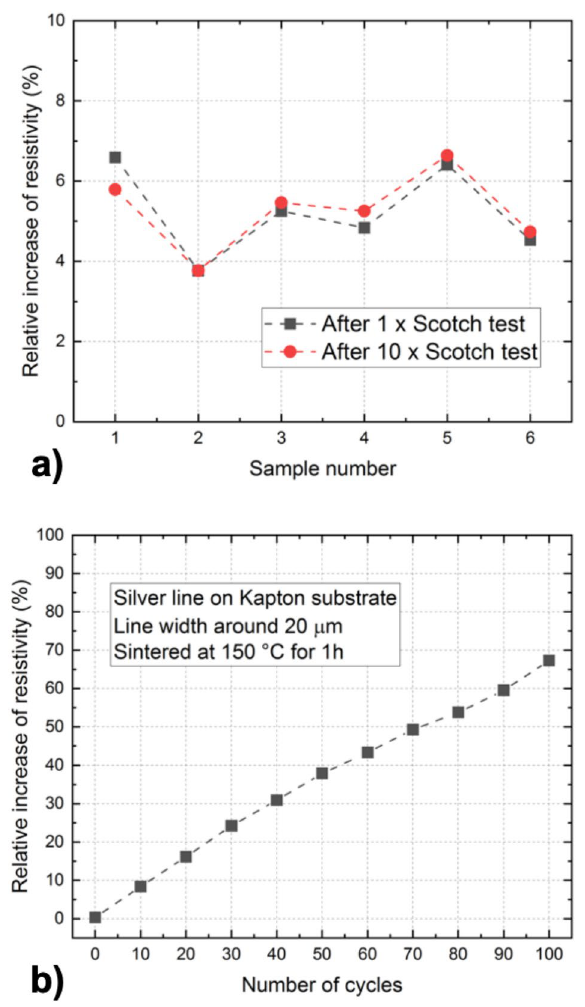
Figure 18. ( a ) Adhesion test of the printed structures: relative increase of resistivity for 5 µm wide silver line after performing 1 × Scotch-tape test and 10 × Scotch-tape test. ( b ) Multiple folding test: relative increase of resistivity as a function of the number of folding